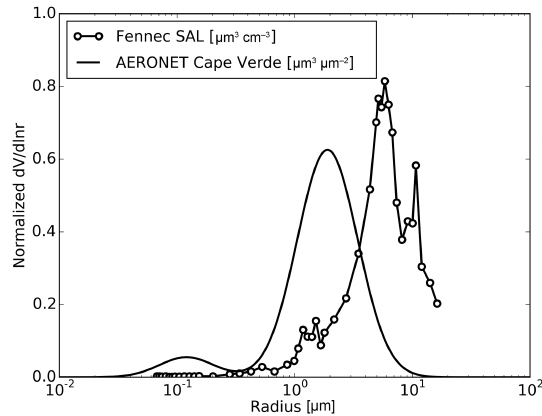
Fennec-SAL curve is from a new in situ measurement of Saharan dust taken during the Fennec 2011 aircraft campaign (Ryder et al., 2013b). The solid curve represents desert dust size distribution re- trieved from AERONET observations at Cape Verde site reported in Dubovik et al.